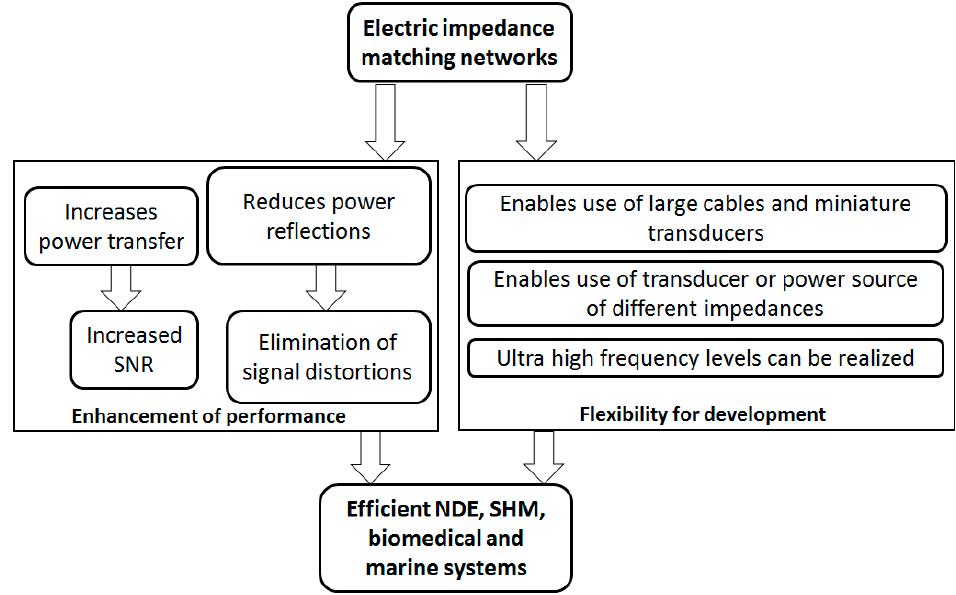
Figure 19. Advantages of using electric impedance matching networks.